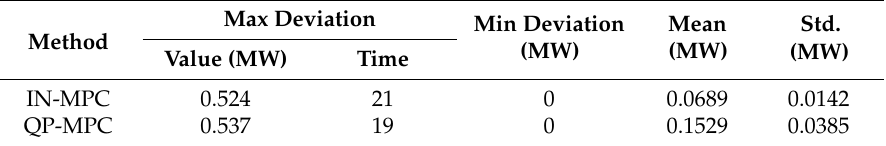
Figure 10. Frequency distribution of dispatching error (9 MWh). Table 2. Statistic result of dispatching error (9 MWh).